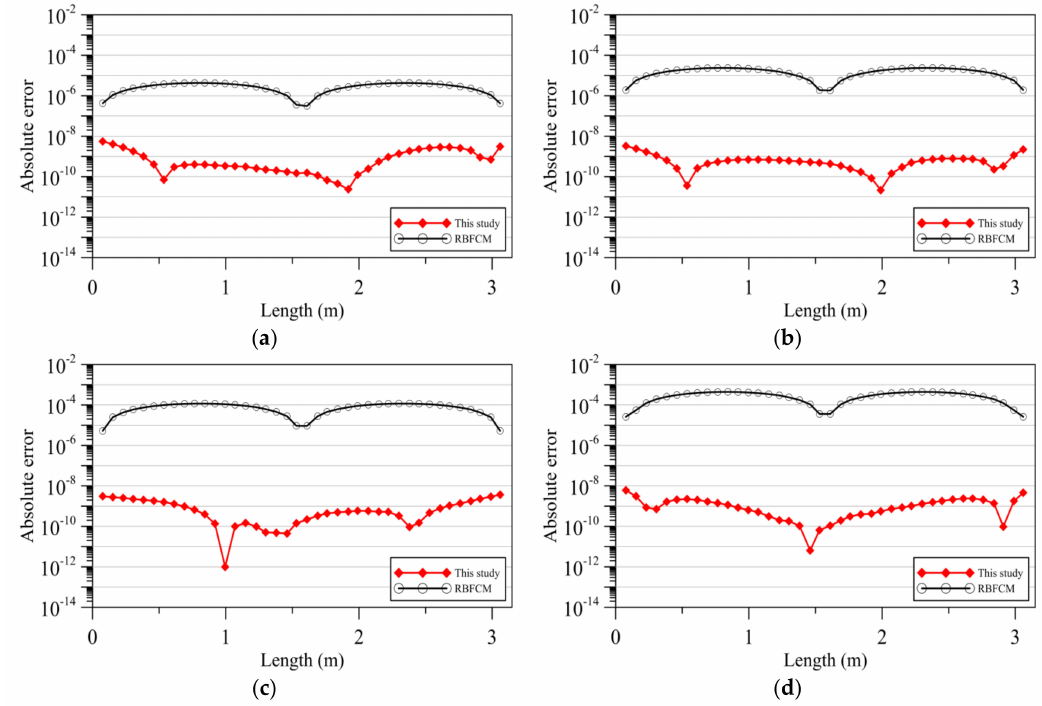
Figure 7. Comparison of the error of the radial basis function collocation method (RBFCM) with the time–marching scheme and our approach at di ff erent time: ( a ) t = 0.5 h; ( b ) t = 1.0 h; ( c ) t = 1.5 h; ( d ) t = 2.0